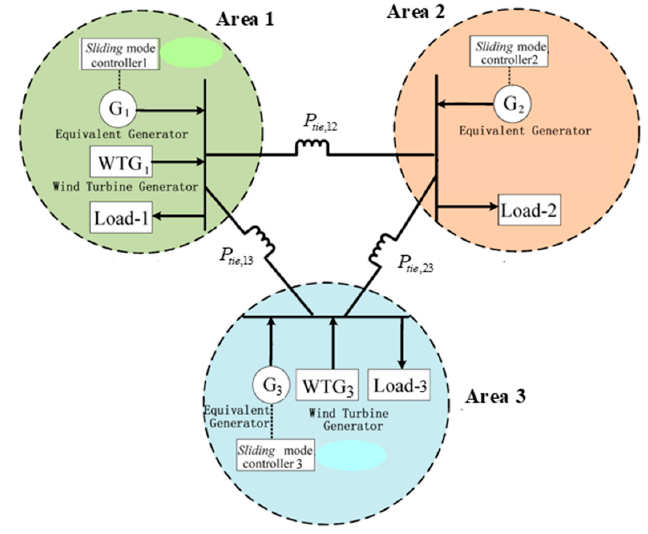
Figure 3. Diagram of a three-area power system integrated with a wind plant. The incremental frequency is displayed in Figure 4 and the tie-line power deviation